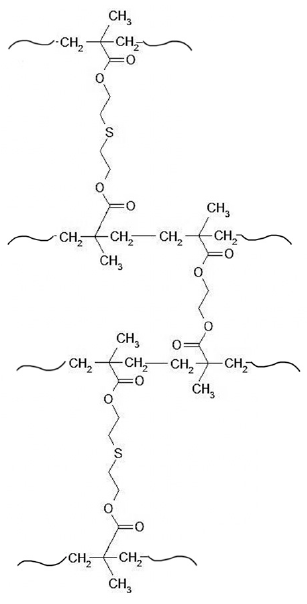
Figure 1. Structure of coP-TEDMA/EGDMA.